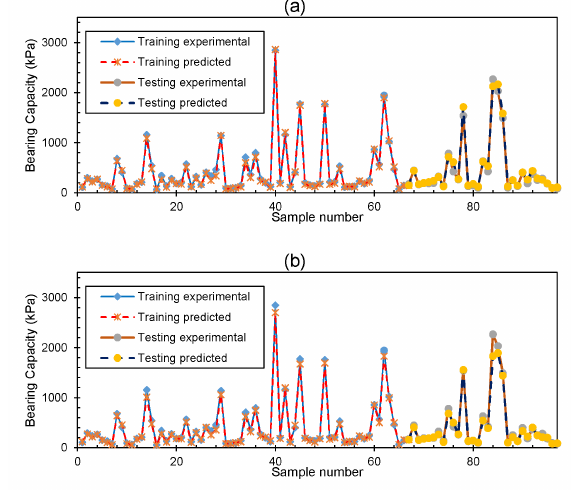
Fig. 9. Experimental and predicted values of bearing capacity of shallow foundation using: (a) the RS-DNN model with 2 hidden layer; (b) MLP model with 1 hidden layer performance in all criteria. Specifically, criteria R 2